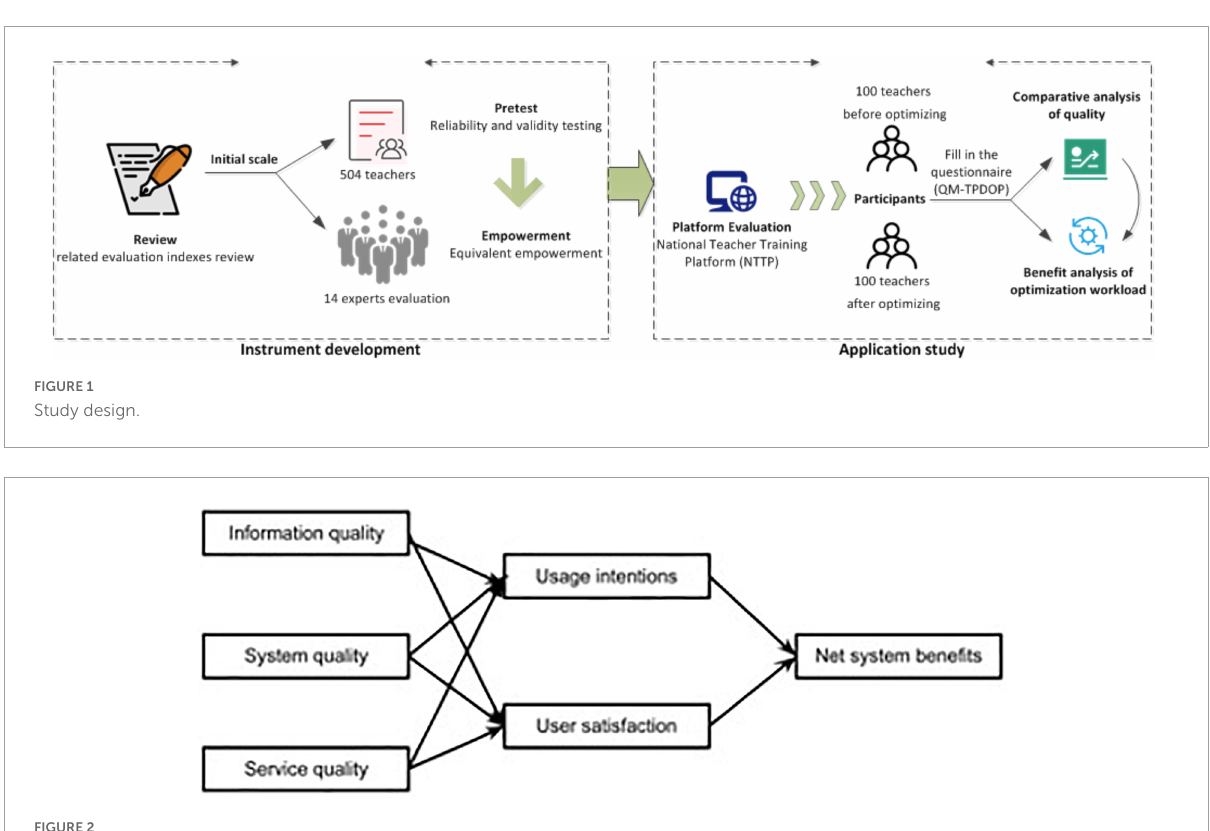
FIGURE2 Information systems (IS) success